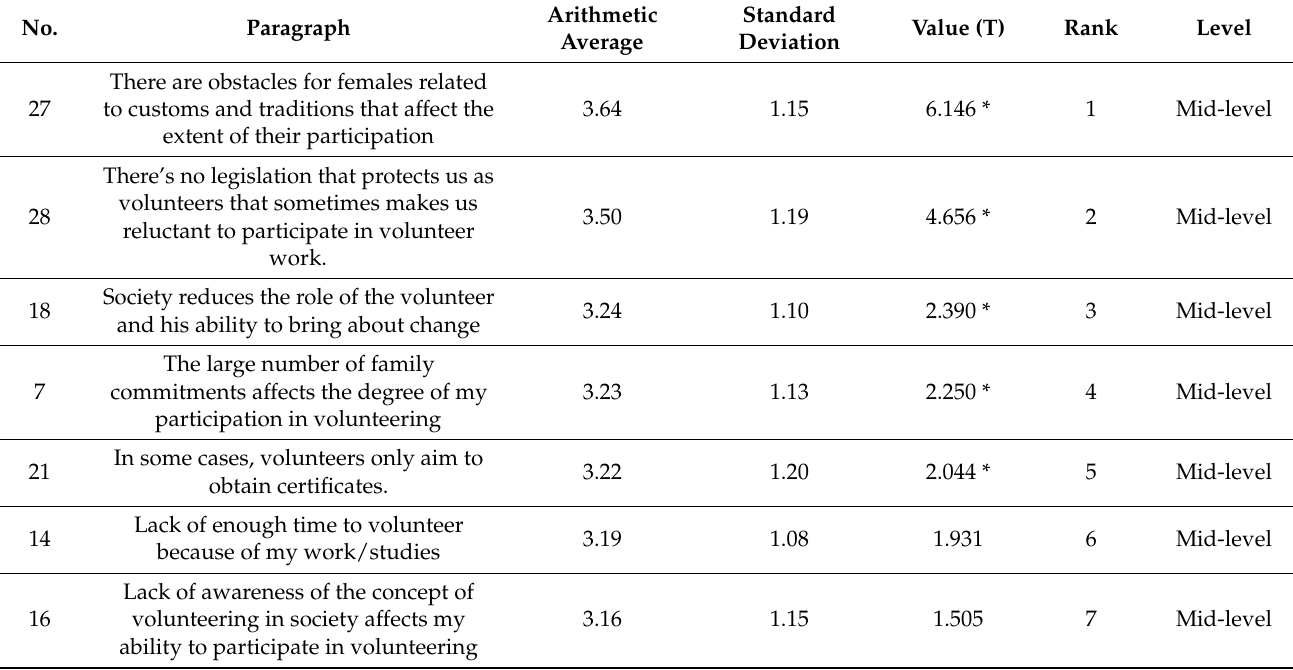
Table 4. Calculation averages and test (t) of the responses of the study sample members to the level of “difficulties faced by volunteers during volunteering during the emerging COVID-19 pandemic” ranked downwards by calculation